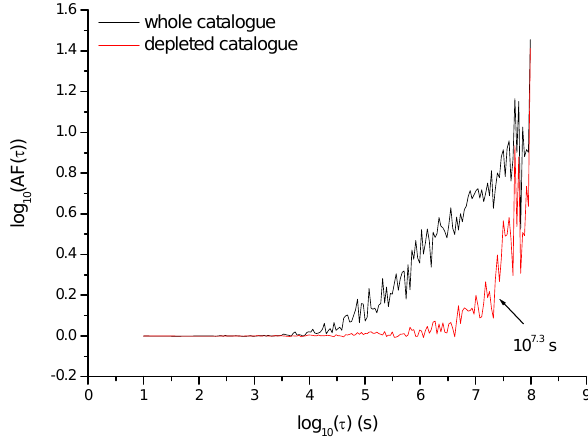
Fig. 10 Fig. 10. Comparison between the AF curve for the aftershock- Fig. 8 Fig. 8. Cumulative number of earthquakes versus time of occur- rence for the aftershock-depleted catalogue. depleted catalogue (black line) and the 95% confidence curve (red line) obtained by means of generation of 1000 Poissonian se- quences.